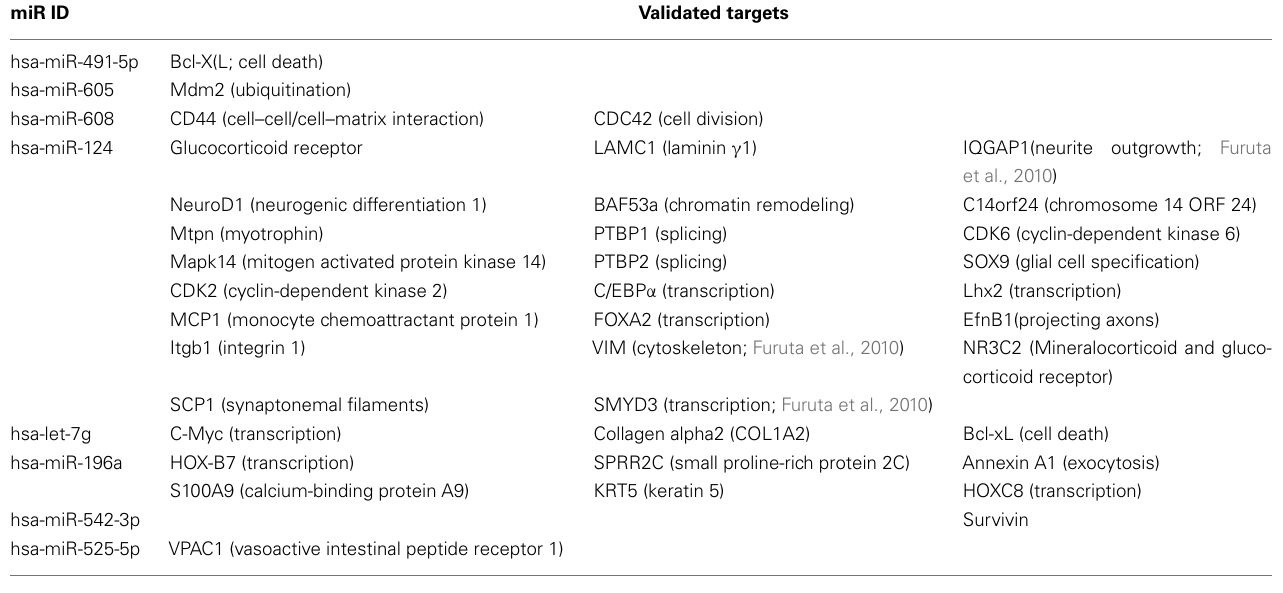
Table 1 |Additional targets ofAChE-S targeting microRNAs.